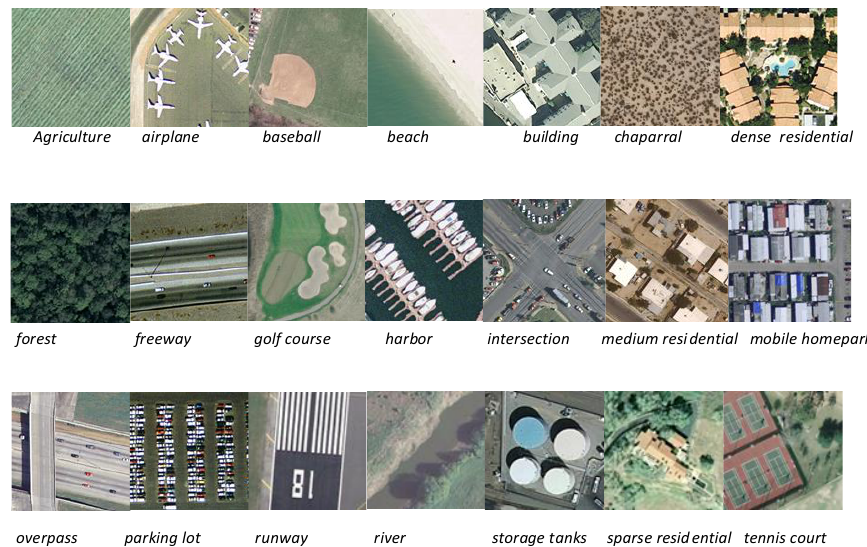
Figure 7. Examples of ground truth data in the UC_MERCED dataset.